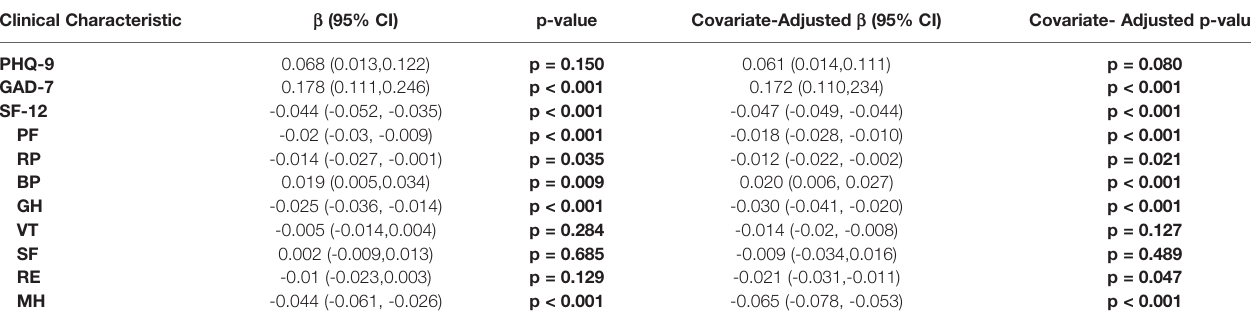
The higher scores for GAD-7 and PHQ-9 are indicative of more negative outcomes, while lower scores for SF-12 measures are indicative of more negative outcomes. Covariates included in the linear regression included age at sex, BMI at enrollment and complication. Bold indicates p <